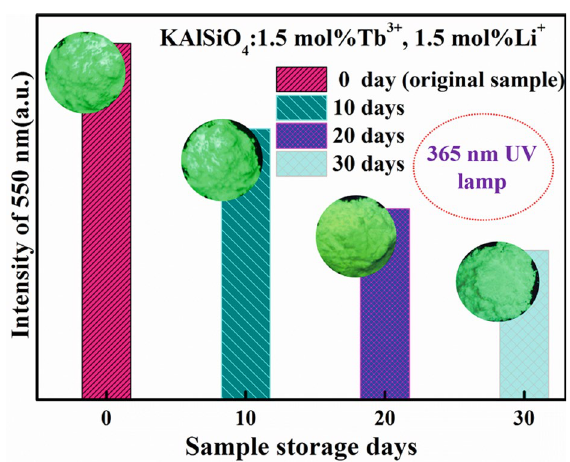
Figure 10. Variation of the emission peak intensity and sample body colour of KAlSiO 4 :1.5 mol% Tb 3+ , 1.5 mol% Li + with number of storage days.